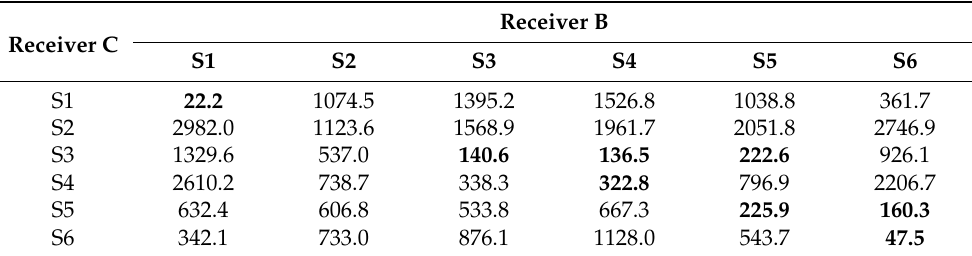
Table 1. The alignment costs of the warping paths of time-series data collected by the novel system, Receiver B and Receiver C, in the dynamic time-warping